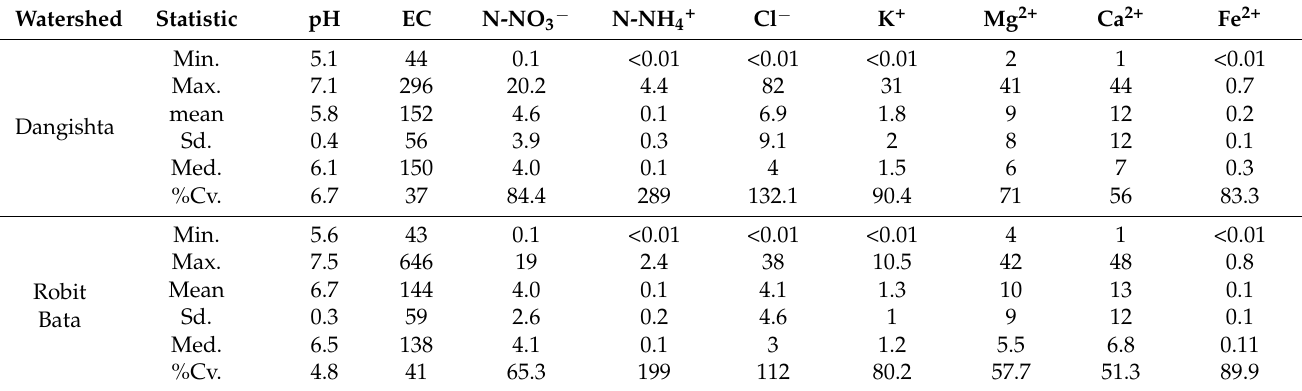
Table 2. Maximum, minimum, and average EC ( µ S cm − 1 ), pH, and constituent concentrations (mg L − 1 ) in the groundwater of Dangishta and Robit